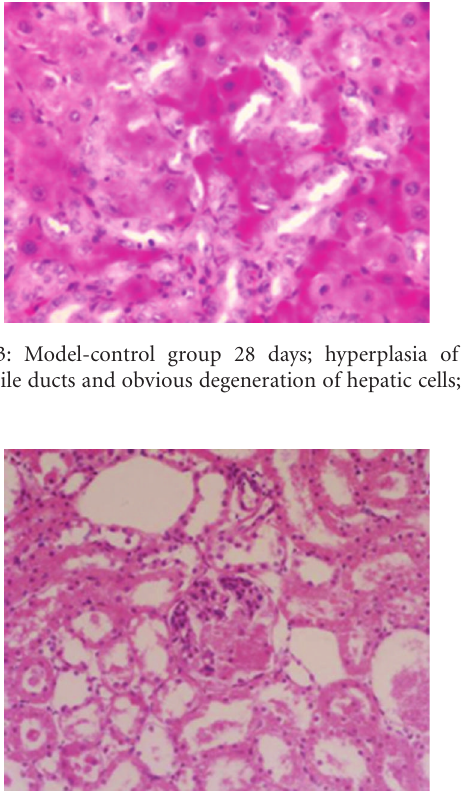
Figure 4: Sham-operated group 28 days; granular substances were seen in the space between glomerular capillaries as well as in the glomerulus and the cytoplasm of renal tubular epithelial cells, and patchy necrosis of renal tubular epithelium was also observed; HE ×